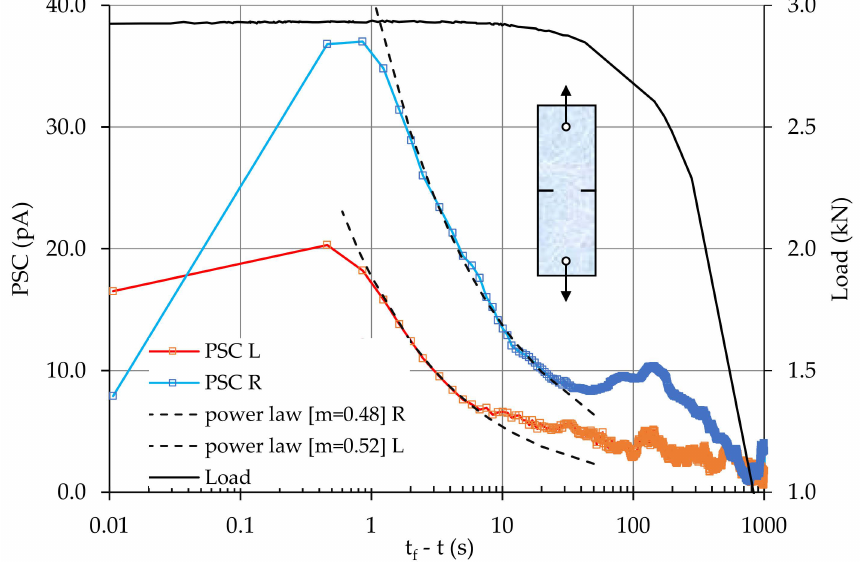
Figure 9. The temporal variation of the pressure-stimulated currents (PSCs) recorded by the two elec- tric sensors, together with the respective variation of the applied